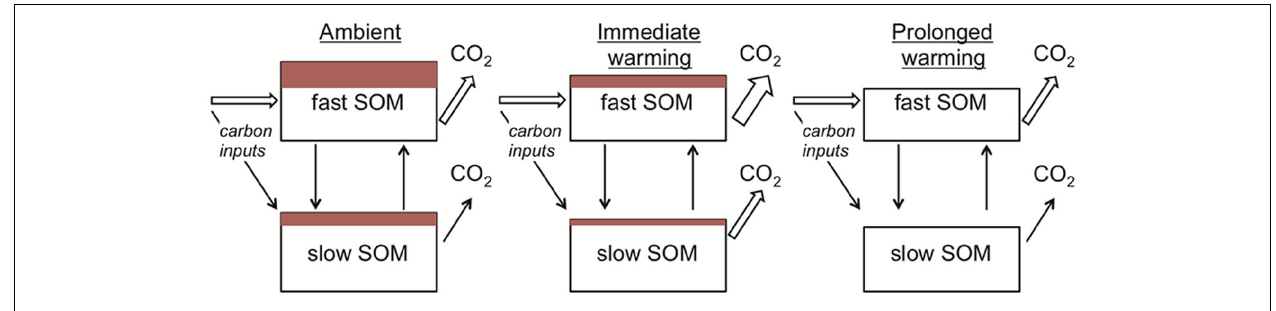
FIGURE 4 |The mechanistic basis for apparent thermal acclimation of soil respiration rates as represented in conventional soil organic matter (SOM) models. Under ambient conditions (left) a proportion of the SOM in both fast and slow pools is vulnerable to loss if temperatures increase (depicted as red-filled rectangles). On warming (middle) respiration rates increase because the rate of SOM turnover is positively related to temperature and a fixed proportion of this turnover is lost as CO 2 .The